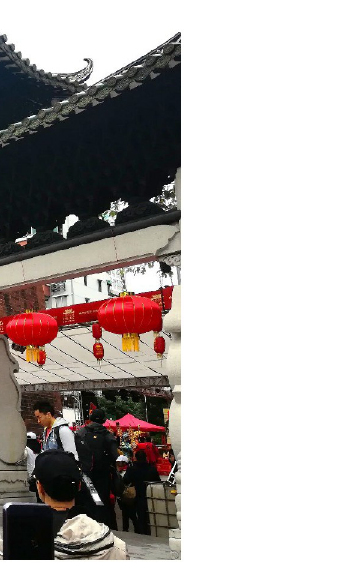
Fig 2. One of the most popular events at the Guangfu Temple Fair: The parade.